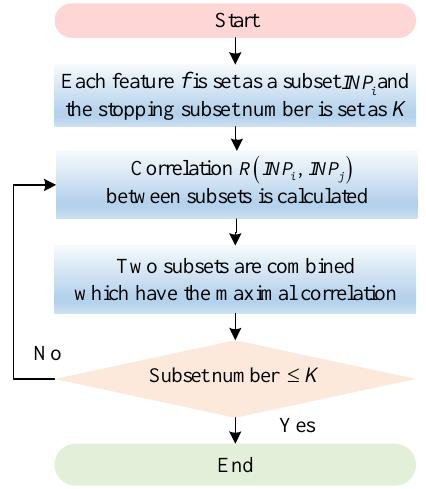
Figure 4. Flow chart of the division